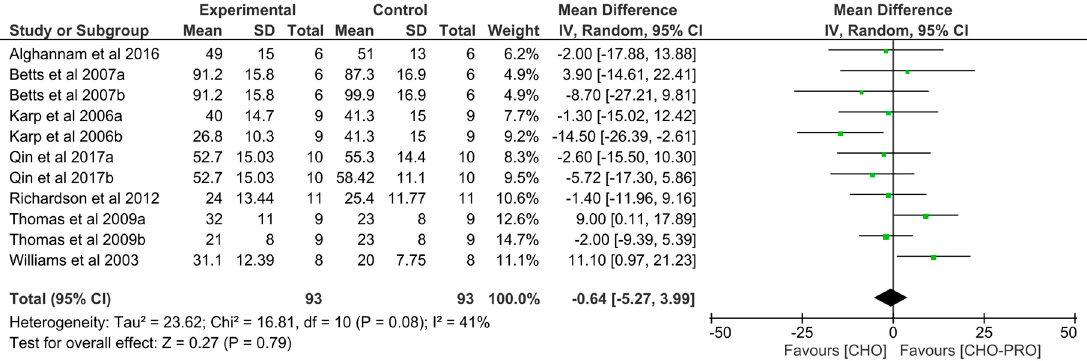
Figure 6. Effect of CHO-PRO intake during short-term recovery on TTE performance compared to CHO. CI: confidence interval; MD: mean difference.